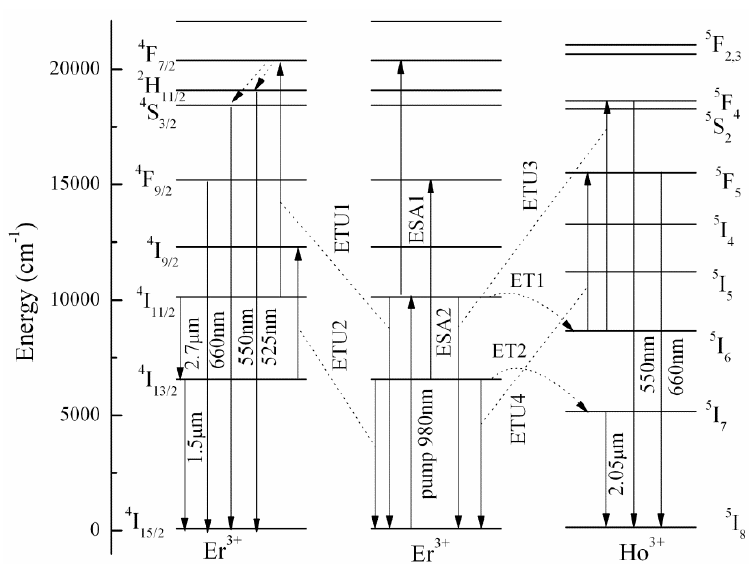
Figure 3. Energy level schemes of Er 3+ and Ho 3+ and energy transfer sketch map between Er 3+ and Ho 3+